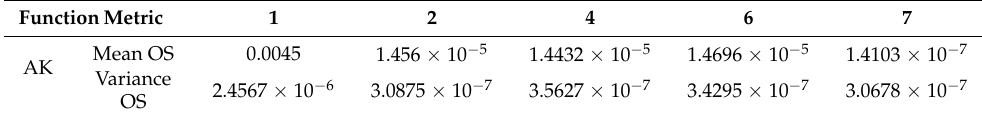
Table 6. Results of different NSP values in each iteration using the AK function. Function